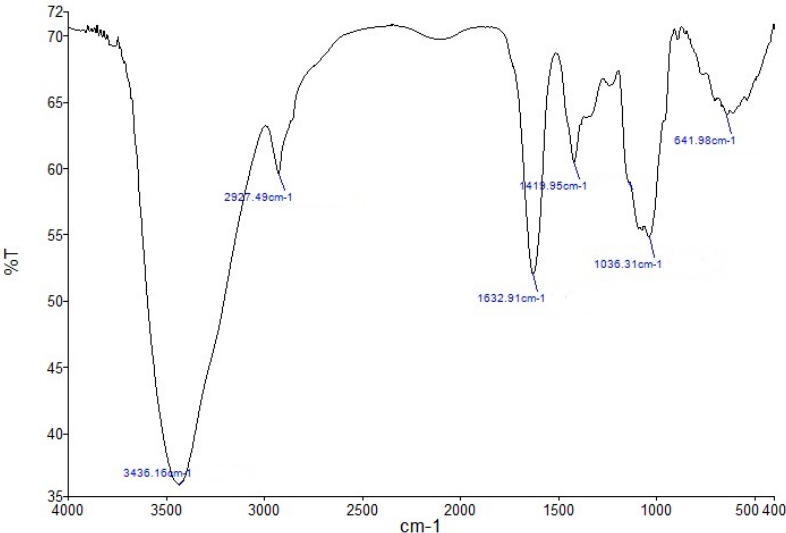
Figure 3. Fourier transform infrared spectroscopy of polysaccharide fraction LCP-I-I. “%T” stands for percentage of transmittance.